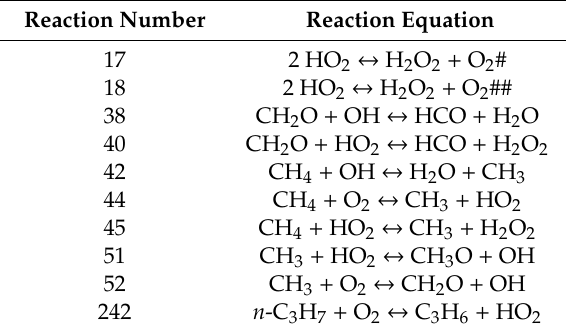
Figure 19. Sensitivity towards CH for methane- n -heptane–air mixtures with a methane content between 50 and 95 mol % in the temperature range of 800 to 1000 K, pressure of 60 bar and a fuel–air equivalence ratio of 0.5, 1.0 and 2.0. Table 3. Overview of the most sensitive reactions shown in Figure 19.